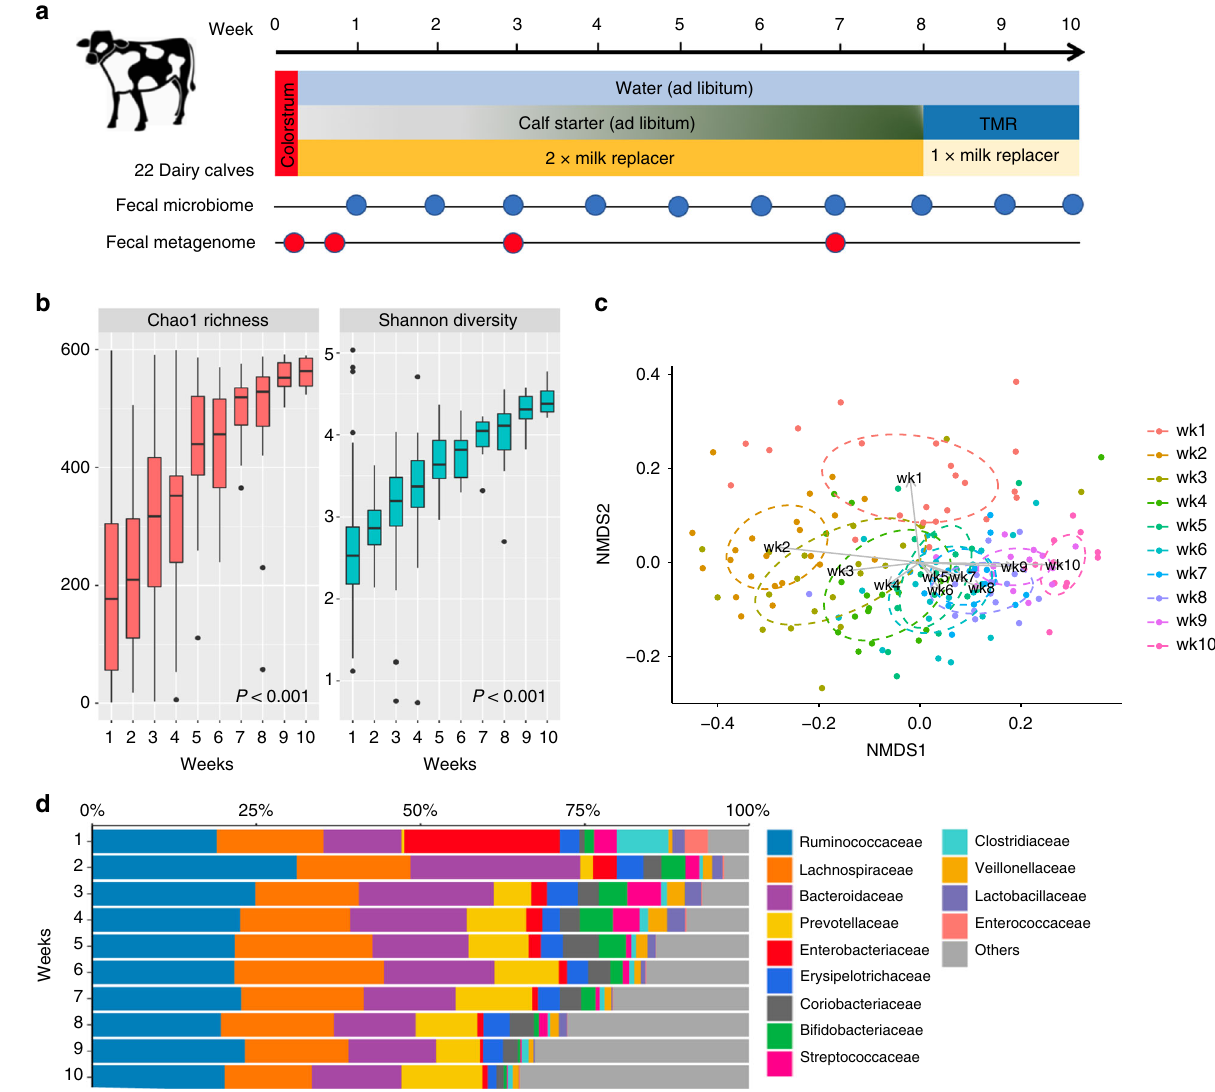
Fig. 1 Dairy calf fecal microbiota changes over the fi rst 10 weeks of life. a The diet, sampling, and sequencing scheme for dairy calves ( n = 22). TMR indicates a total mixed ration diet. b Boxplots of alpha diversity as measured by Chao1 richness and Shannon diversity index. The Chao1 richness and Shannon index values were presented as the median (central black horizontal line); the lower and upper hinges correspond to the 25th and 75th percentiles. Outliers are displayed as small black circles. c 2-dimensional NMDS of dairy fecal samples based on GUniFrac (stress = 0.16). Subsampling to obtain equal sample size ( n = 22) at each time point was completed prior to performing the ordination analysis and PERMANOVA. The centroid of each ellipse represents the group mean, and the shape was de fi ned by the covariance within each group. d Bar plot depicting the relative abundance of bacterial families over time; unclassi fi ed taxa and bacterial families which has a relative abundance less than 1% were grouped into “ Others